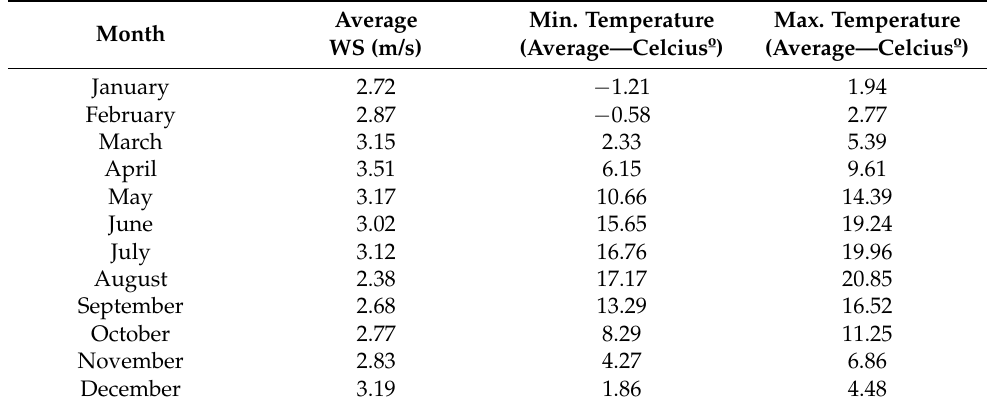
Table 3. Average WS, minimum temperature, maximum temperature per month in Gda´nsk between